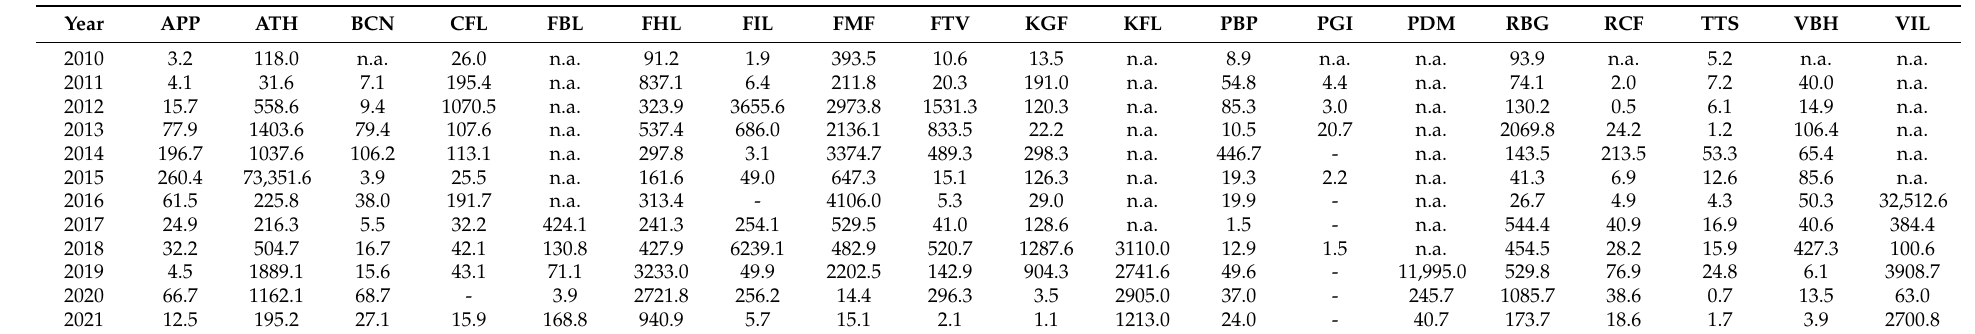
Table 10. Volume of Trades Per Year (in